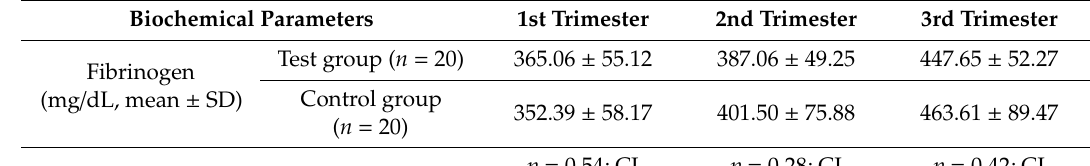
Table 3. Evolution of biochemical parameters during